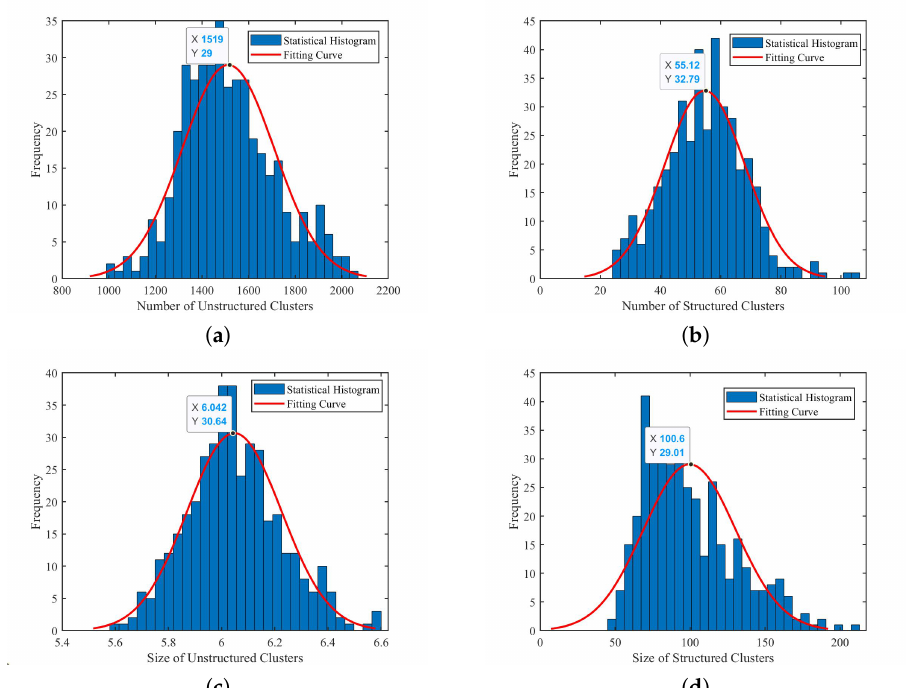
Figure 7. Comparison of segmentation results between structured and unstructured objects. ( a , b ): Dis- tribution of the number of unstructured and structured clusters in each frame, respectively. ( c , d ): Dis- tribution of the average size of unstructured and structured clusters in each frame, respectively.